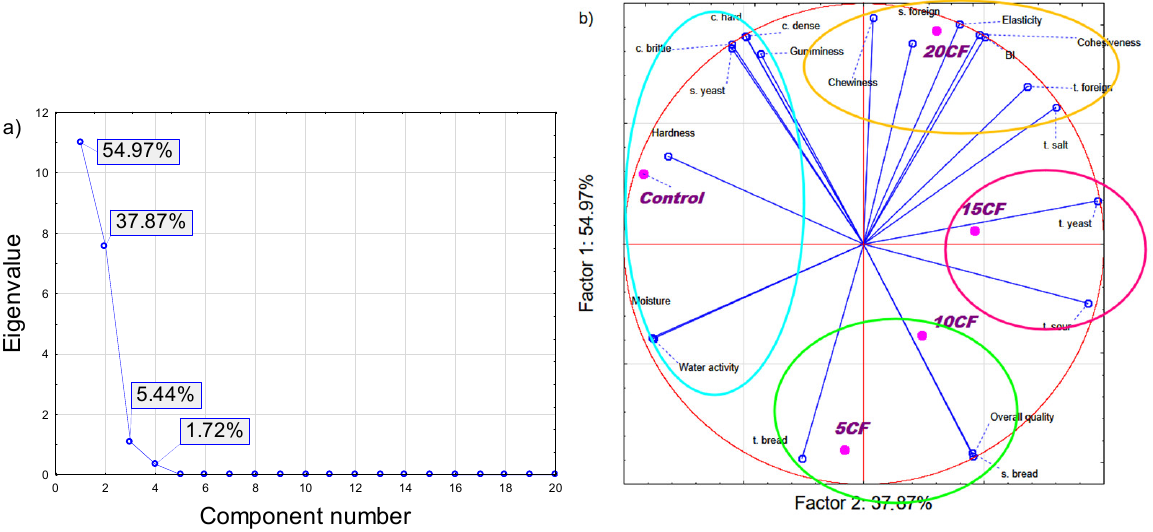
Figure 9. Principal component analysis (PCA) of the following samples: Control—control sample, gluten-free breads with the addition of chestnut flour in the amount of 5% (5CF), 10% (10CF), 15% (15CF) and 20% (20CF). BI—browning index, ‘c.’ stands for crumb, ‘s.’ stands for smell, t. stands for taste. Eigenvalues for each individual principal component is presented in ( a ), but ( b ) presents importance of chosen factors.